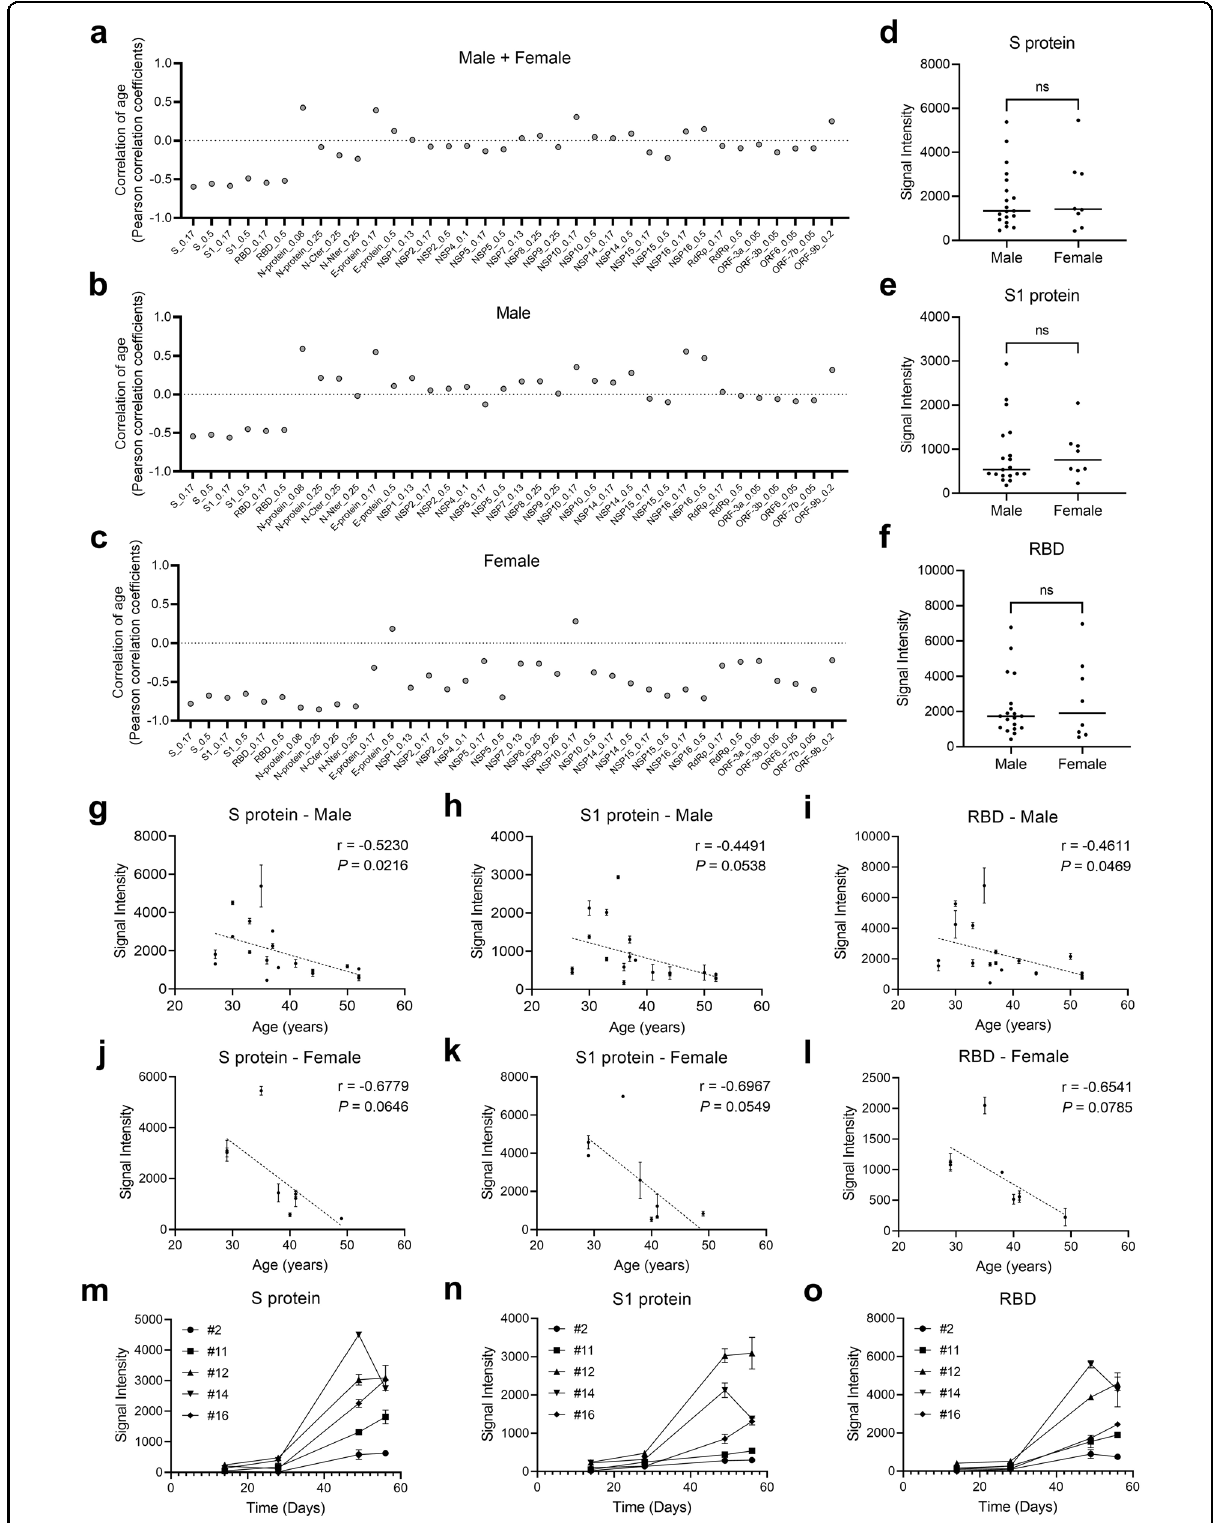
Fig. 2 Correlation of protein (S, S1, or RBD)-speci fi c IgG responses to age or gender. a Correlations of the overall IgG responses to age. b , c Correlations of IgG responses to age for males ( b ) and females ( c ). d – f IgG responses of males vs females to the S protein ( d ), S1 subunit ( e ), and RBD ( f ). The P value were calculated by the Student ’ s t- test. g – l Correlations of IgG responses to age for males and females for individual proteins, i.e., the S protein ( g ) and ( j ), S1 subunit ( h ) and ( k ), and RBD ( i ) and ( l ). m – o Trends of IgG responses to the S protein ( m ), S1 subunit ( n ), and RBD ( o ). Values are presented as the mean ± SEM. Unless otherwise stated, sera collected after the 2nd vaccine dose were